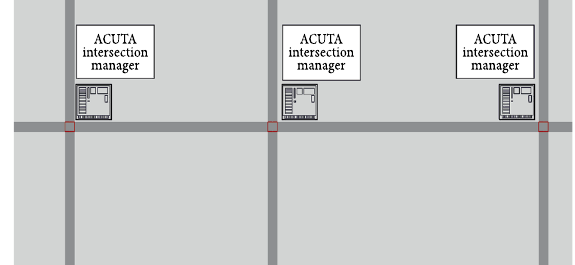
Table 6. Comparison of CO emission between single-tile ACUTA and four-way stop control